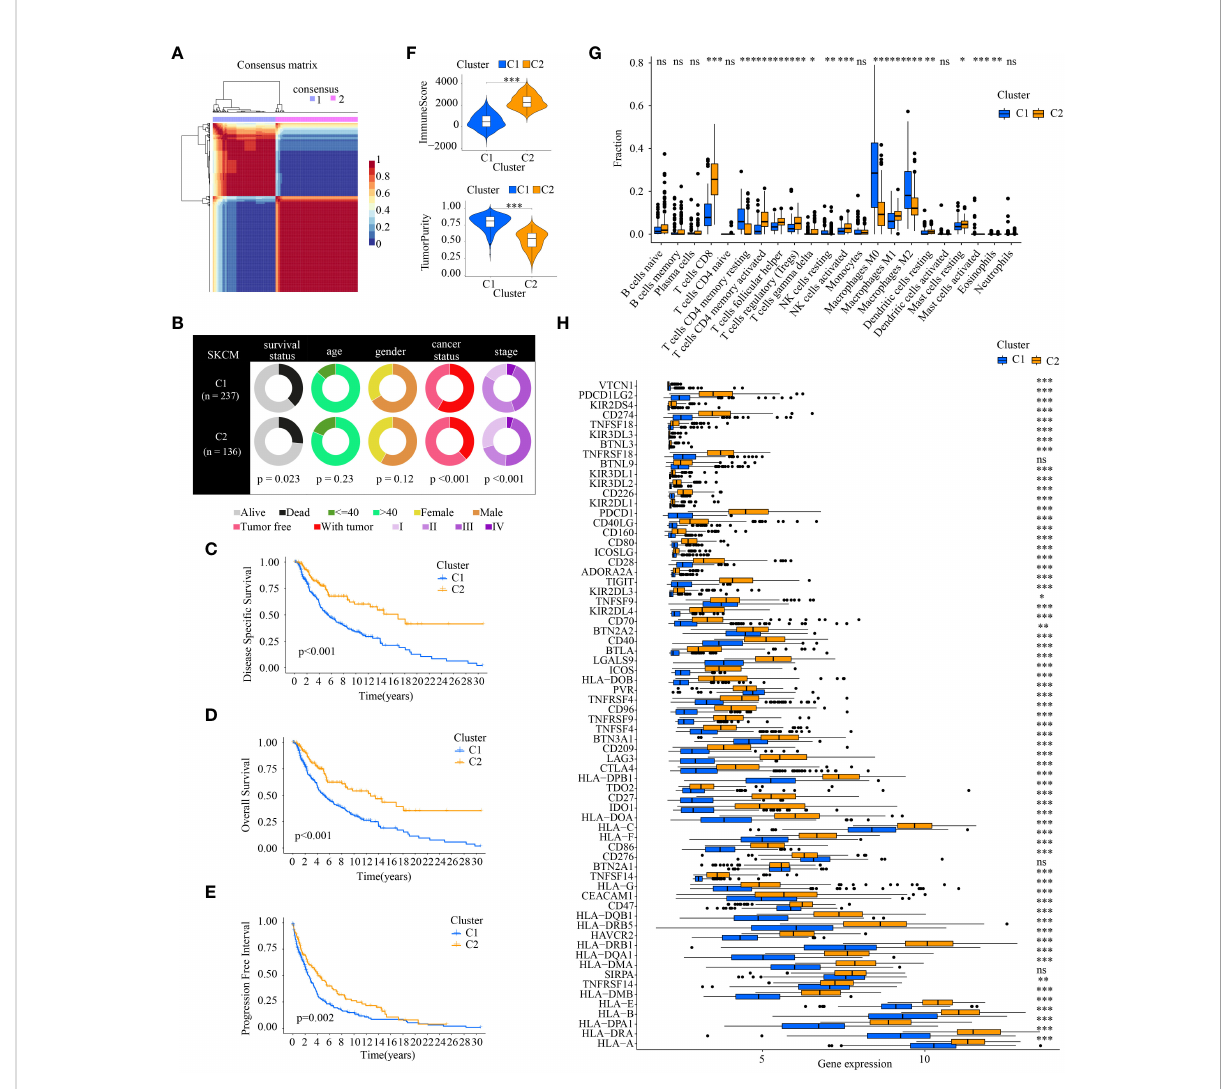
FIGURE 3 Comparison of the clinical traits, survival status, tumor immune microenvironment between different cluster subtypes obtained by NMF clustering. (A) The optimal clustering number of 2; (B) Pie charts illustrating the clinicopathologic factors in the two molecular subtypes; (C – E) Kaplan – Meier analyses (DSS, OS and PFI) based on the two molecular subtypes; (F) Comparison of TME components; (G) Discrepancy analysis of tumor-in fi ltrating immune cells in different subtypes; and (H) Differential expression analysis of 68 immune checkpoints genes between two molecular subtypes.(* indicates p <0.05; ** indicates p < 0.01; *** indicates p < 0.001; ns: p >